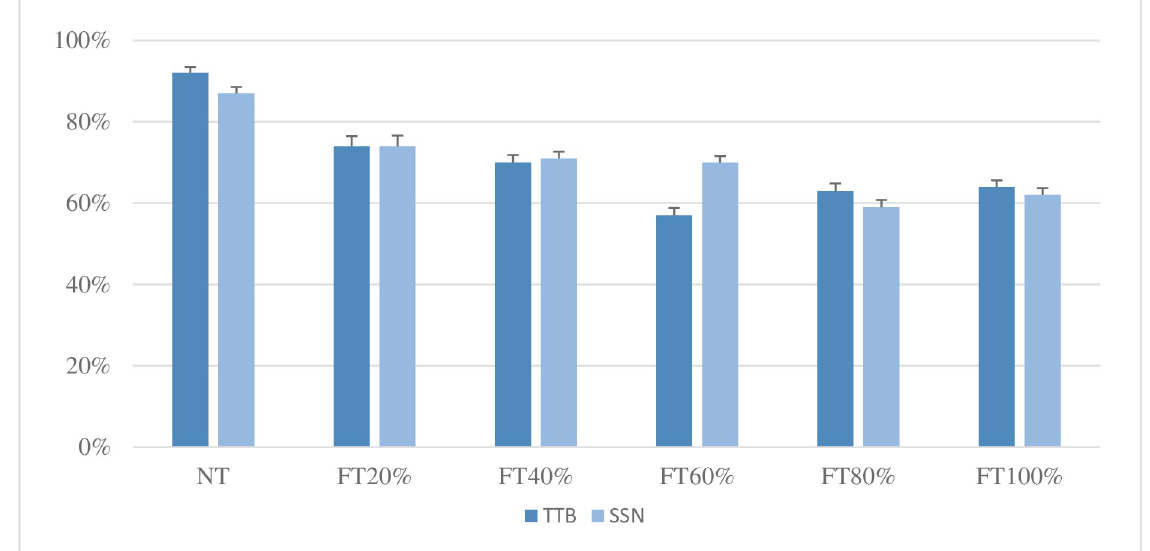
Fig 2. Mean Cantonese sentence recognition scores (percentage of words identified correctly) in speech-shaped noise (SSN) and in two- talker babble noise (TTB) conditions. NT, FT 20%, FT 40%, FT 60%, FT 80%, and FT 100% represent 0%, 20%, 40%, 60%, 80%, and 100% of words manipulated in a sentence,